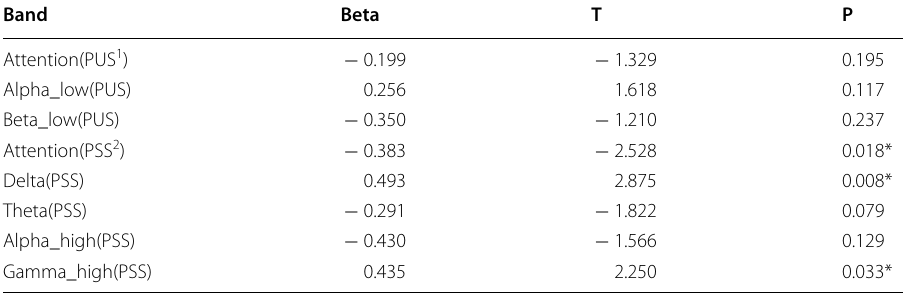
*p < 0.05 Table 4 Results of linear regression in identifying important performance predictors from BS levels in brainwave